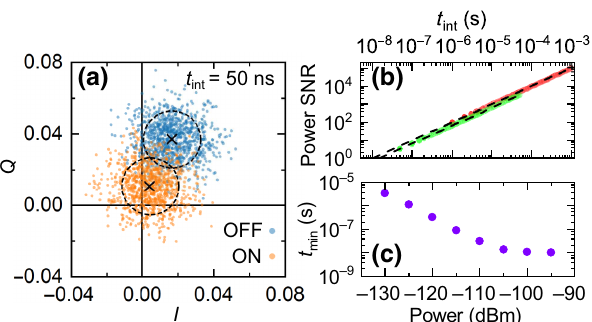
FIG. 3. Readout performance evaluation. (a) Distribution of the reflected signal in quadrature space, collected at the two points marked in Fig. 2(a) on and off the ICT signal. Each point is collected with an integration time t int = 50 ns. For each dis- tribution, the black cross marks the mean and the dashed circle indicates the standard deviation of distances to the mean. (b) SNR dependence on t int for input power = − 100 dBm. Red data points are taken with a 1-MHz low-pass filter and the green data points are taken with a 20-MHz low-pass filter. The dashed lines extrapolate the data to SNR = 1, from which we extract the minimum integration time, t min . (c) Decrease in t min with increas- ing input power, which saturates due to power broadening at approximately 100 dBm [49].